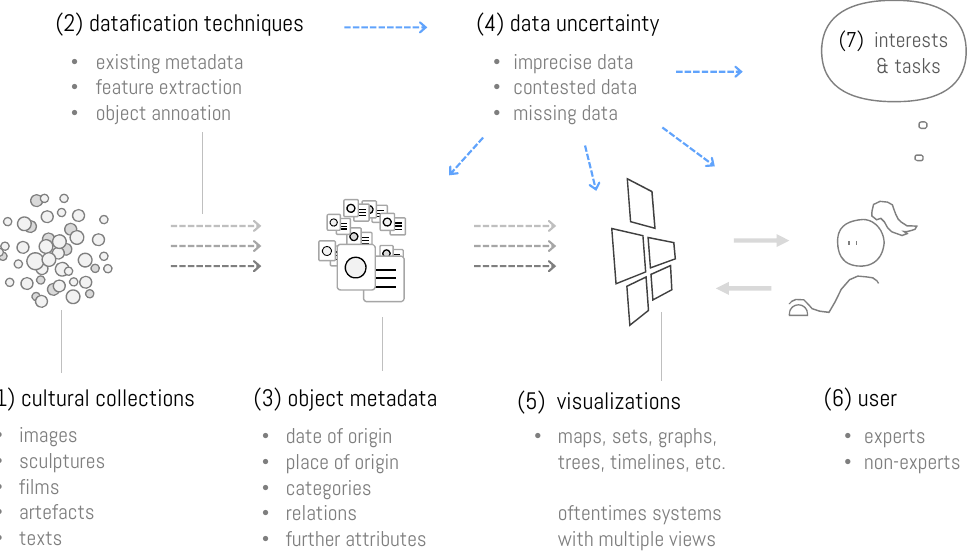
Figure 1. Digital cultural collections and their metadata are affected by different types of uncertainty (4), which have rarely been visualized and studied up to